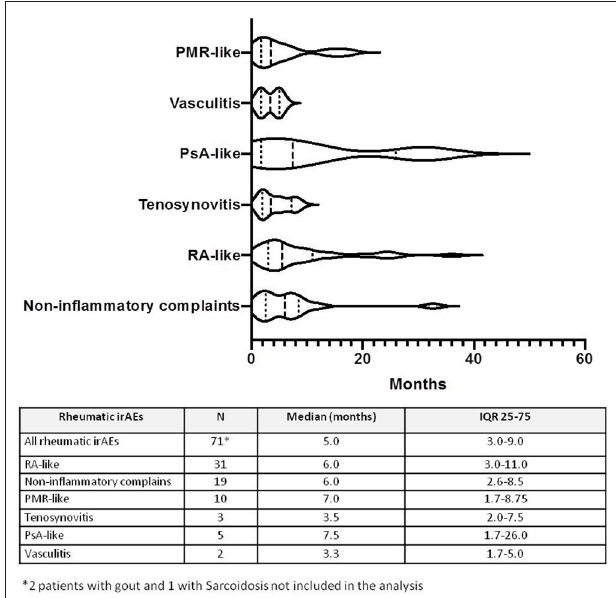
FIGURE 1 | Time to onset from ICI initiation and Rheumatic irAEs according rheumatic